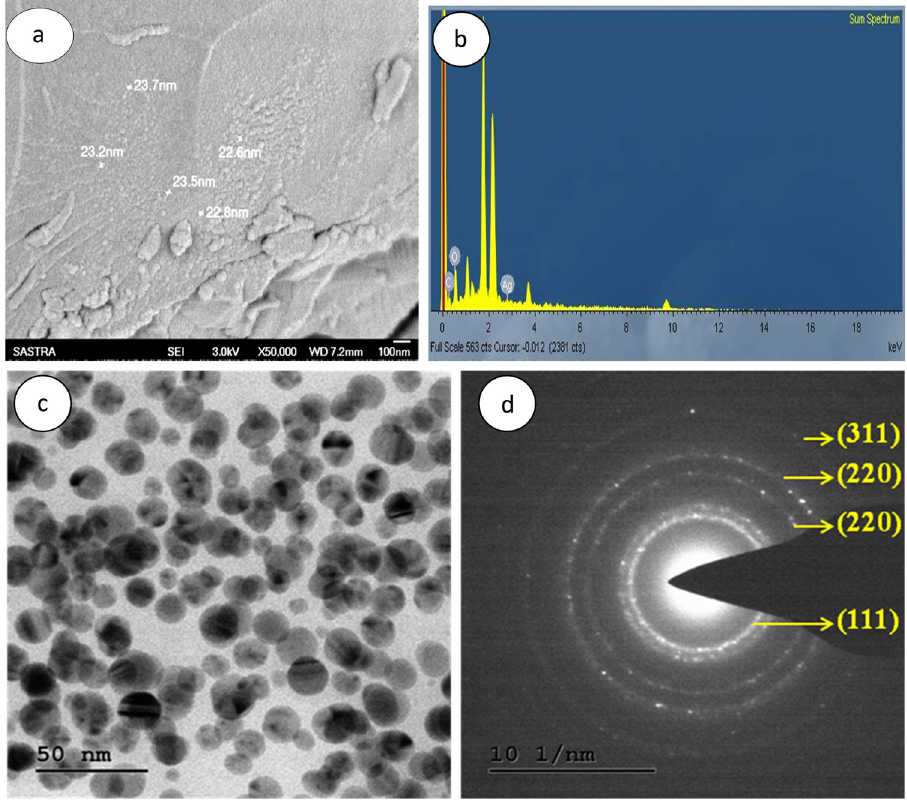
Figure 4: ( a ) SEM, ( b ) EDX, ( c ) TEM, and ( d ) SAED images of synthesized AgNPs using A. monophylla